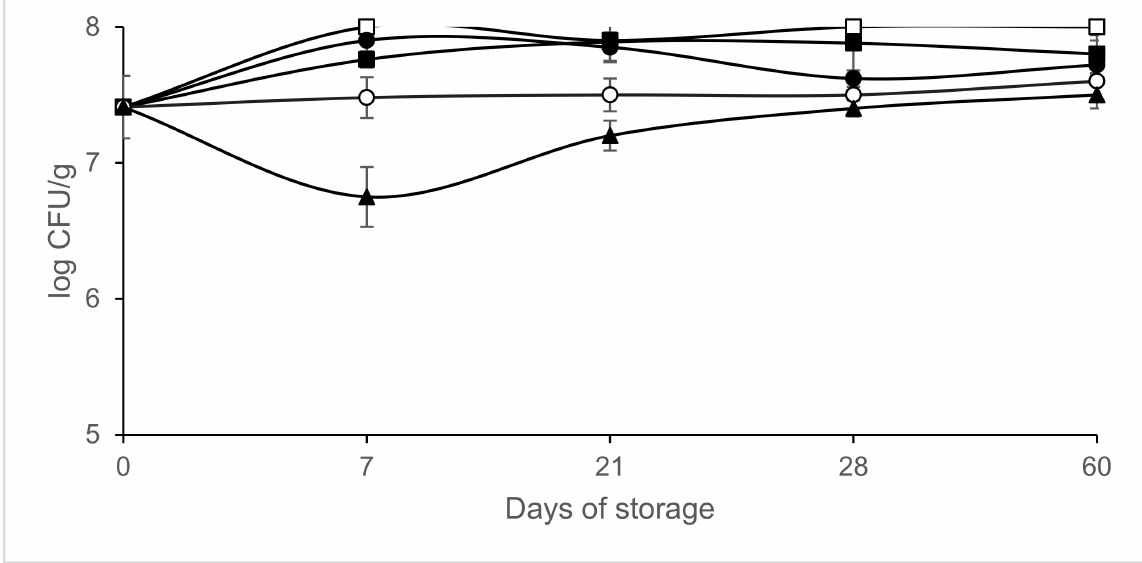
), 40% CO 2 /60% N 2 ( (cid:78) (cid:35)